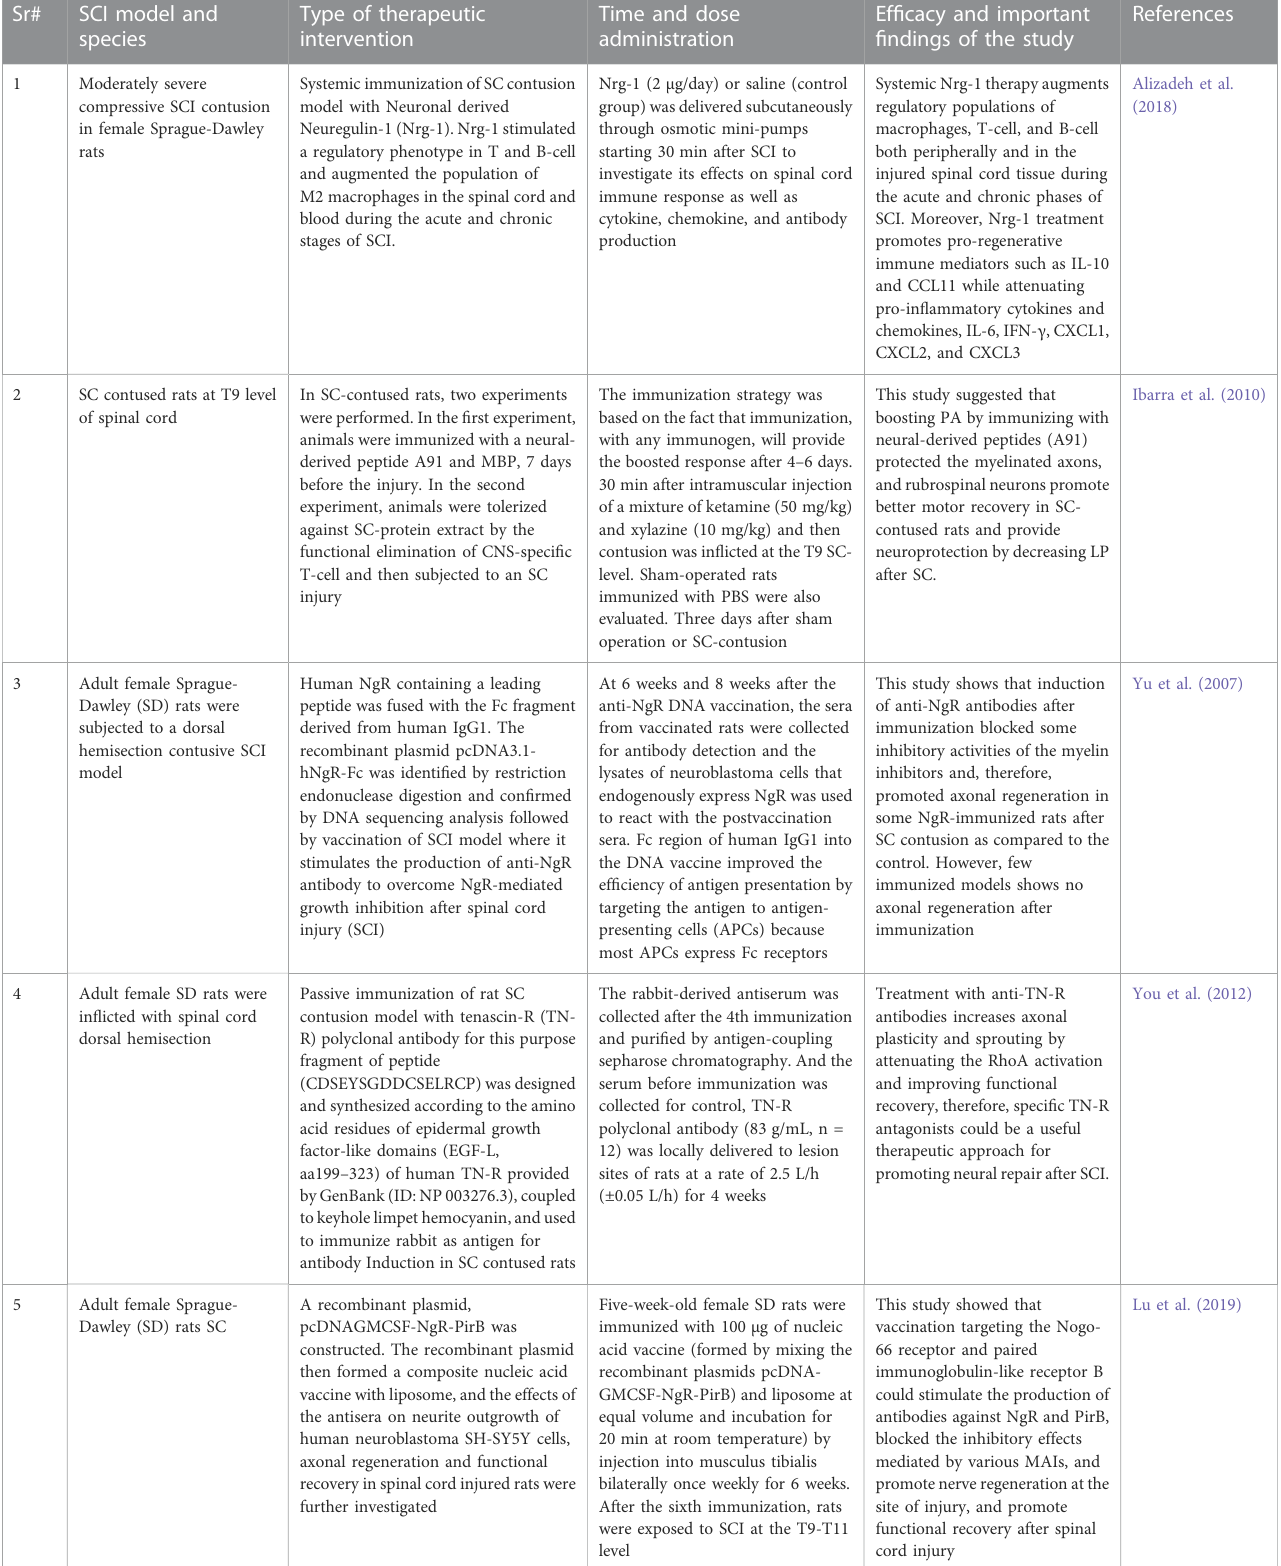
TABLE 1 Summary of studies using immunotherapy to treat spinal cord